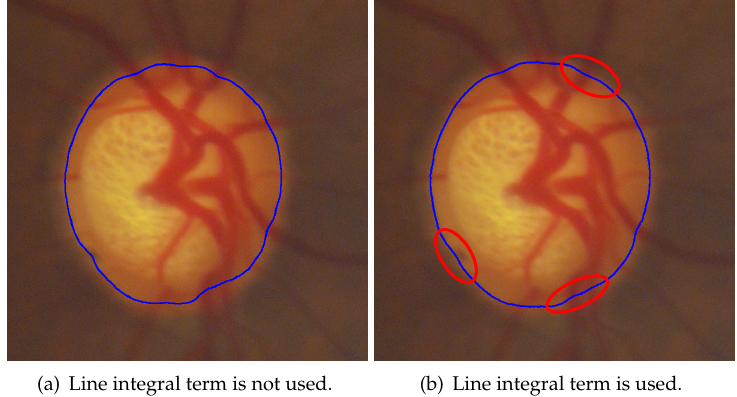
Figure 5. Comparison of using and not using a line integral term; ( b ) the contour was significantly smoother than that in ( a ). (blue contour: results of segmentation, red area: obviously smoother part). The formula of the area-based term is shown in Equation (9), where u 0 is the average pixel values of the whole image, and c 1 , c 2 are the average pixel values inside and outside the contour, respectively. The area-based term evolves the contour through the difference of the average pixel values between the inside and outside of the contour, and the weight of inside and outside can be controlled by λ in and λ out . As shown in Figure 6, when the boundary of an object is fuzzy, the gradient of the boundary is low. If using the gradient- based energy functional, the contour does not converge or even disappear. The area-based term is based on the pixel difference; therefore, it can achieve excellent performance in low-contrast and low-gradient images.